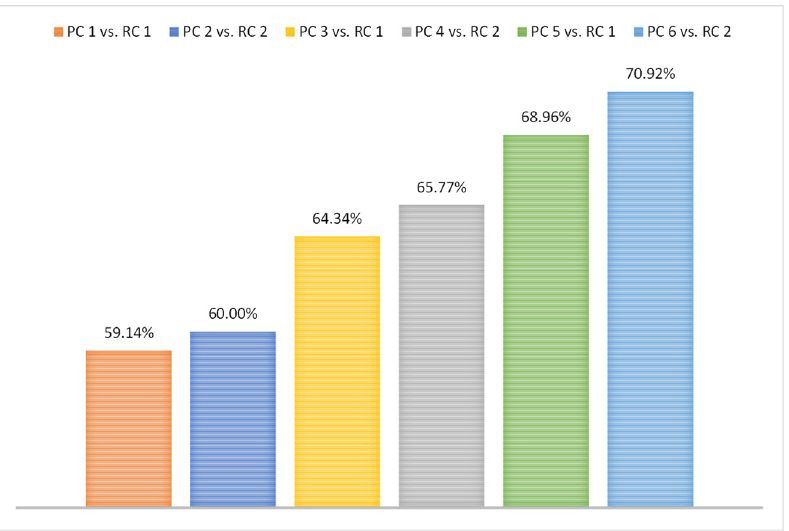
Figure 12. Percentage reductions in peak voltages calculated across the terminals of insulators: comparisons between reference and proposed cases.